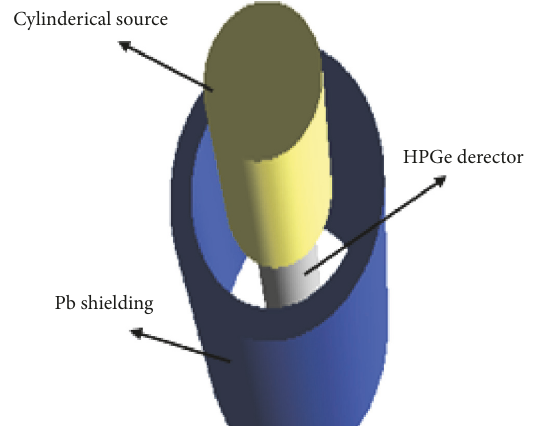
Figure 4: A model of radioactive cylindrical source and HPGe detector shielded by lead.